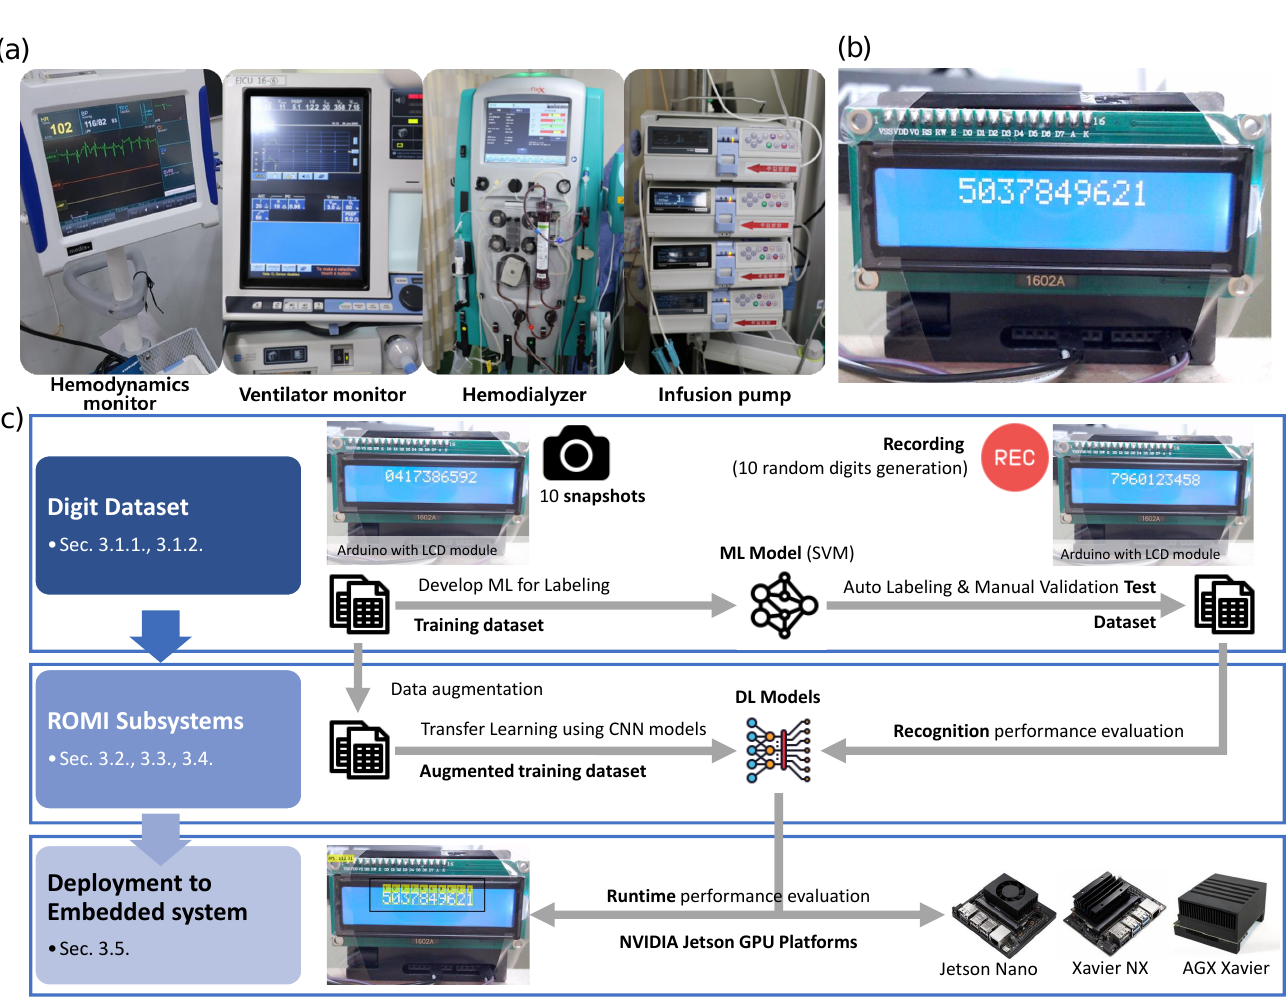
Figure 2. A real-time optical digit recognition embedded system. ( a ) Medical devices in ICUs. ( b ) A proof-of-concept device. ( c ) Flow diagram of the development of